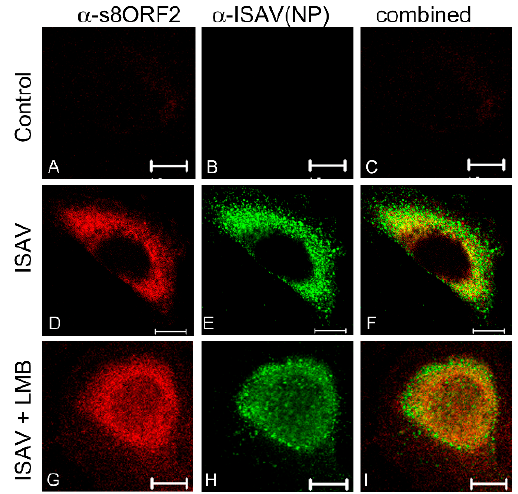
Figure 3. Subcellular localization of the s8ORF2 protein following treatment with the CRM-1 dependent nuclear export inhibitor leptomycin B (LMB). The s8ORF2 protein displays both cytosolic and nuclear localization and was retained in the nucleus following addition of leptomycin B (LMB). ISAV infected ASK cells were 48 h post infection exposed to 40 µM LMB for 4 hours followed by immunostaining with anti-s8ORF2 antibody (red) and anti-NP antibody (green). ( A – C ) Non-infected control cells; ( D – F ) ISAV infected cells; ( G – I ) ISAV infected and LMB exposed. Images were captured by confocal microscopy at 63x magnification. Combined signals = yellow. Scale bar = 10 µm.